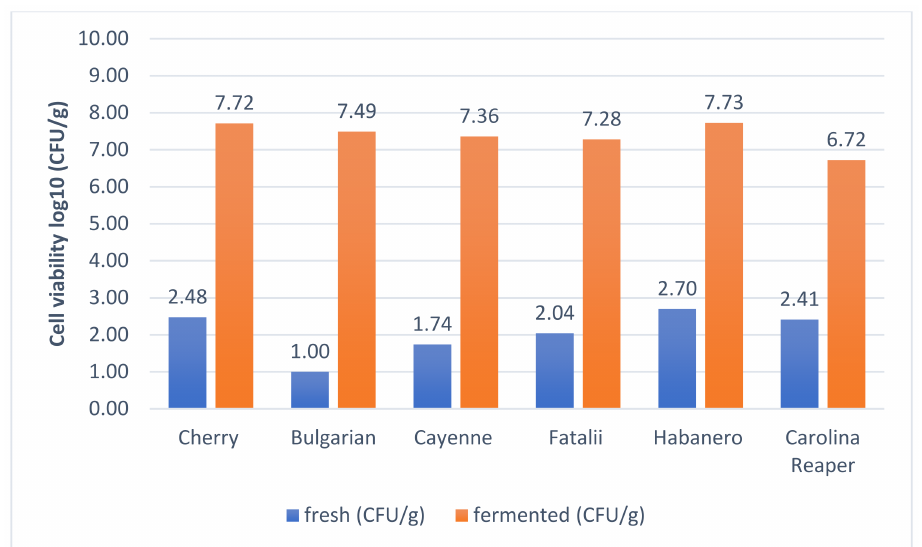
Figure 3. Viability assay of Leuconostoc bacteria in day 0 and day